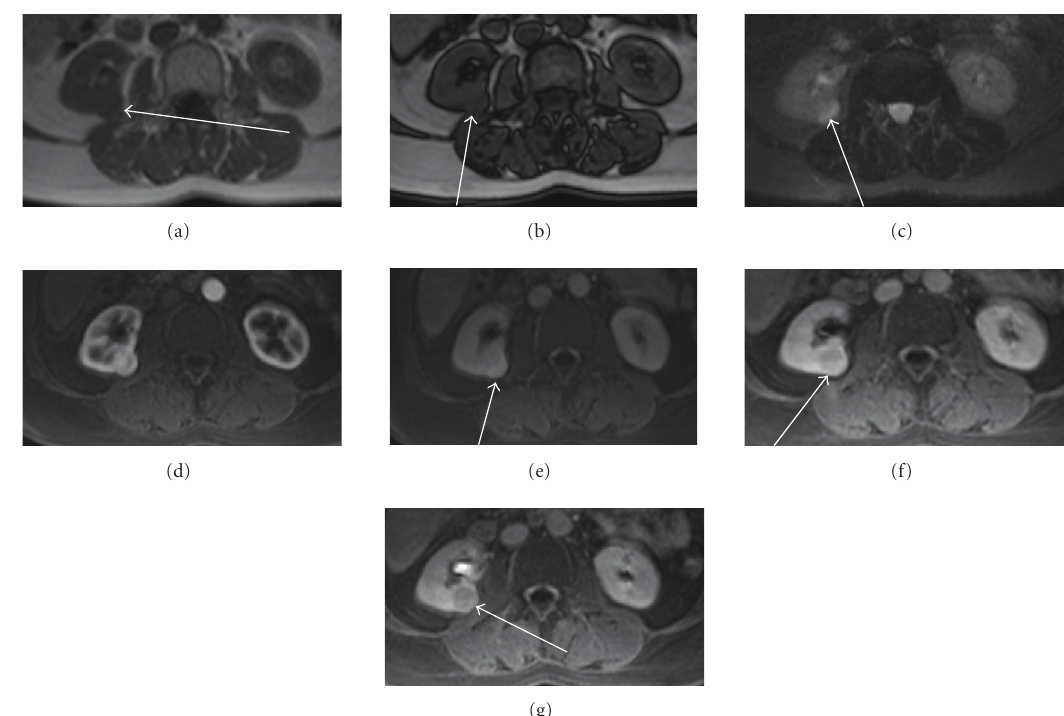
Figure 14: (a) Axial T1 in phase, (b) axial T1 out of phase, (c) axial stir, and (d–g) axial dynamic postcontrast T1 ((d) arterial; (e) venous; (f) nephrographic, and (g) excretory phase). A nonfatty mass hyperintense on T2 and highly vascular on corticomedullary and nephrographic phase with late mild washout as is shown on this clear renal cell carcinoma.